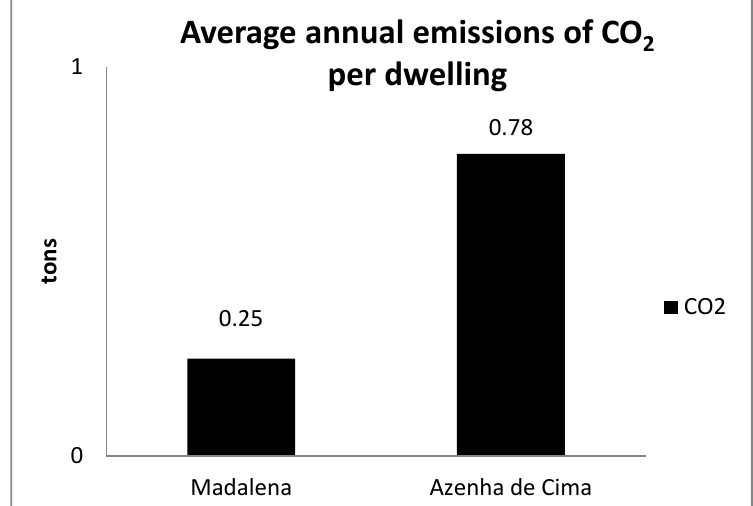
Figure 2. Average CO annual emissions—Madalena vs . Azenha de Cima. 2